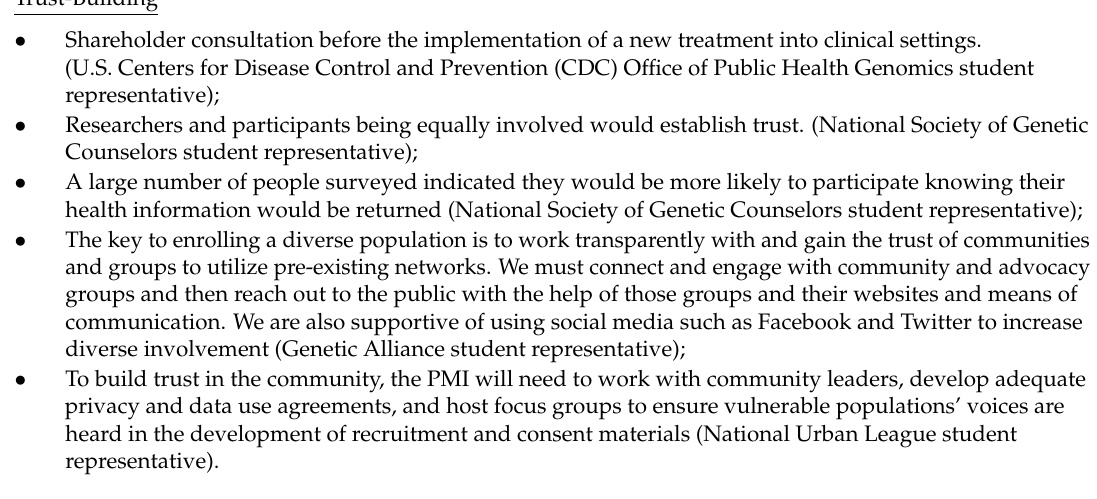
Table 2. Student responses in key precision medicine and public health class exercise